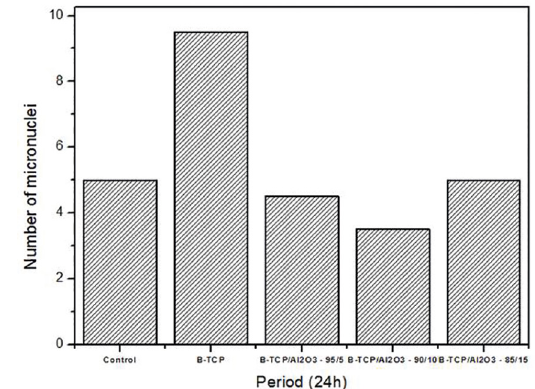
Figure 7. Graph showing mean percentage of absorbance, obtained with MTT assay, after contact of the cells with β-TCP/Al scaffolds for 24 hours.